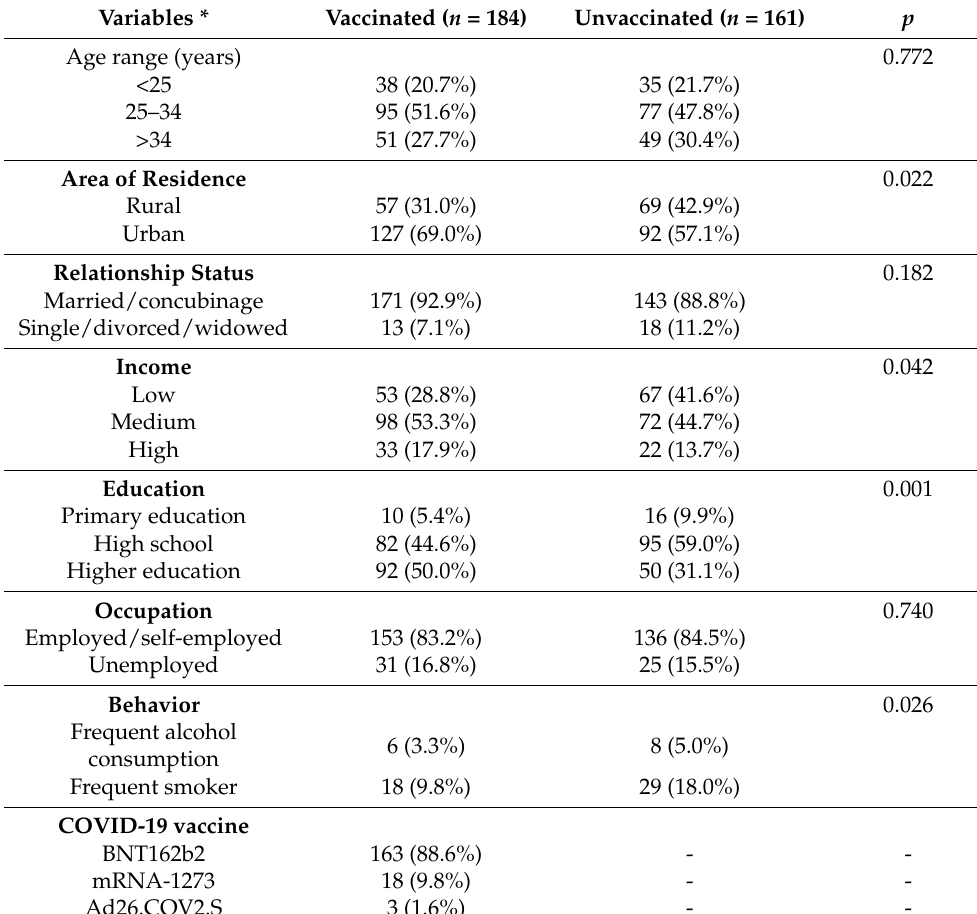
Comparison in baseline characteristics between vaccinated and unvaccinated pregnant